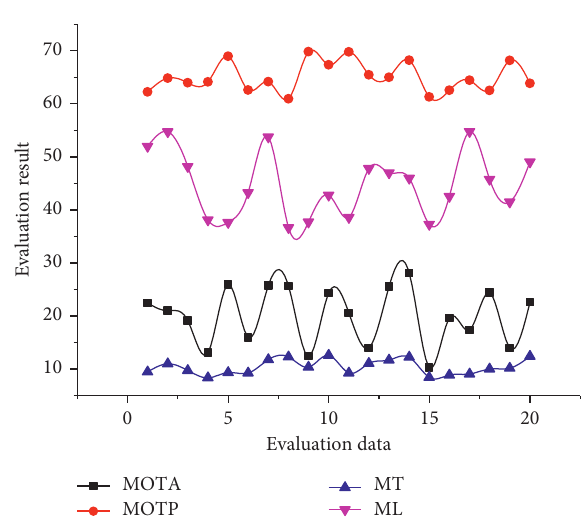
Figure 7: Tracking time comparison.